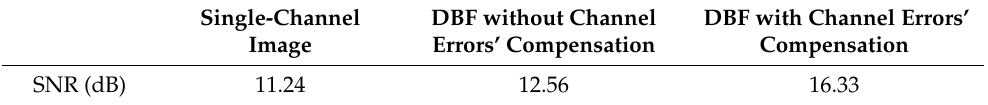
Table 6. SNR comparison.